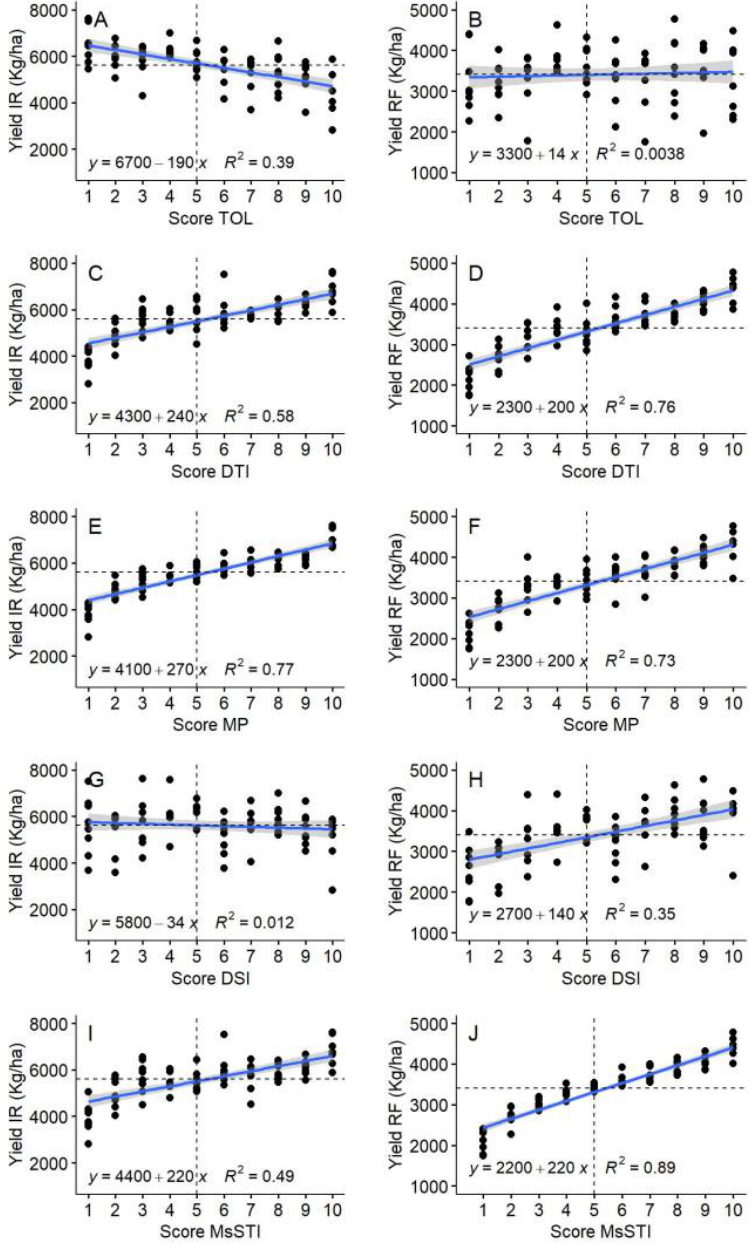
Figure 2. Linear regression and coefficient of determination of grain yield under irrigation (IR) and rainfed (RF) conditions at Tessaout versus the scores’ indices. TOL, tolerance ( A , B ), DTI, drought tolerance index ( C , D ), MP, mean productivity ( E , F ), DSI, drought susceptibility index ( G , H ), and MsSTI, modified stress tolerance index ( I , J